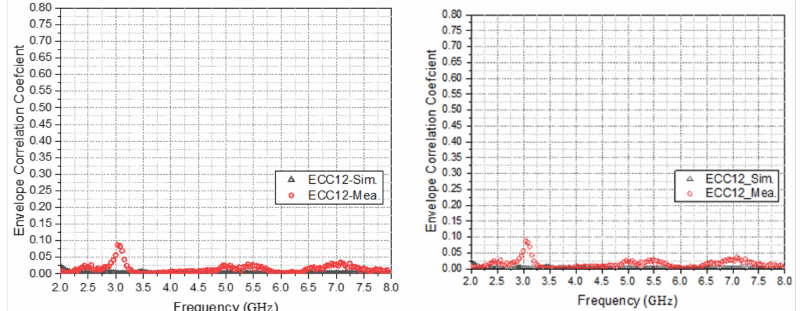
Figure 23. Comparison of ECC simulation and actual measurement between Ant. 1 and Ant. 2.